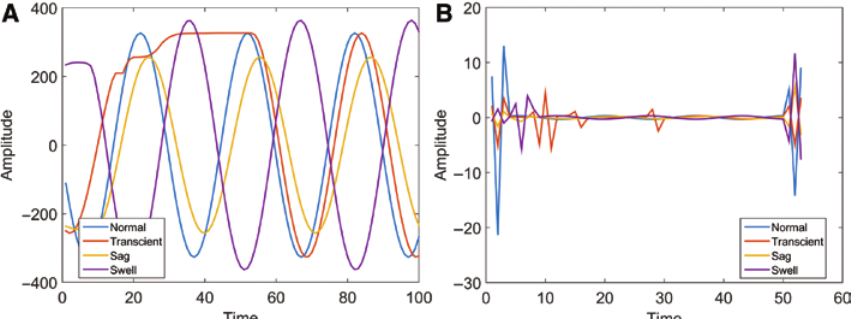
Figure 5: Pattern of Signal Descriptors Showing Normal and Fault Signals: (A) Temporal Signals and (B) Wavelet